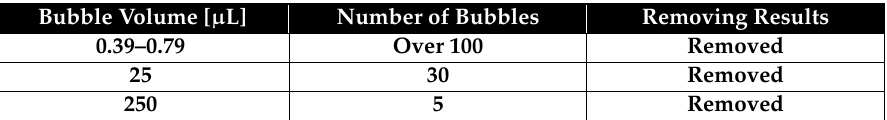
Table 1. Detailed bubble volume information and bubble removal